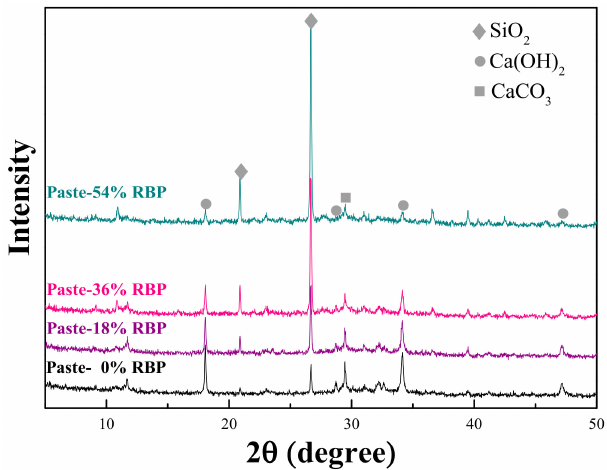
Figure 5. Compound composition of paste with various replacement of RBP by XRD test.